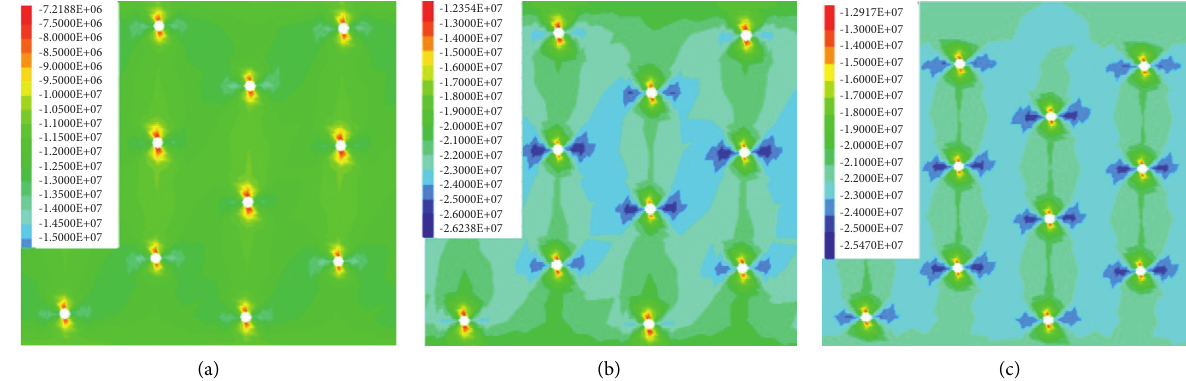
Figure 6: Vertical stress distribution of 100 mm pressure relief hole at different depths along the axis direction. (a) 2 m from the coal rib. (b) 4 m from the coal rib. (c) 6 m from the coal rib.